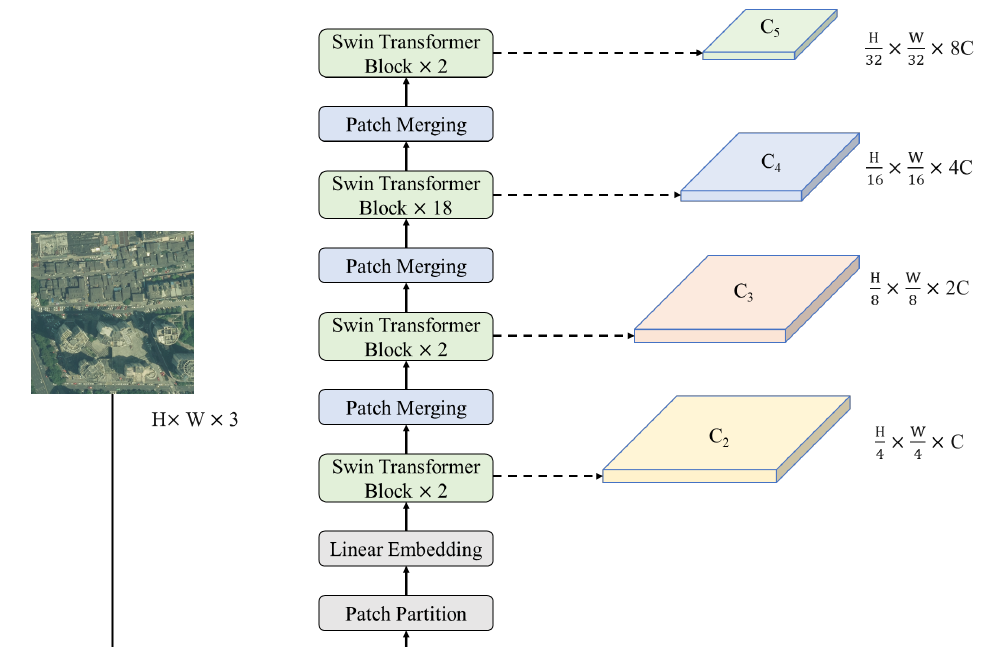
Figure 5. Swin Transformer Encoder. The input is satellite images of size H × W × 3, and the output is feature maps of four different scales.